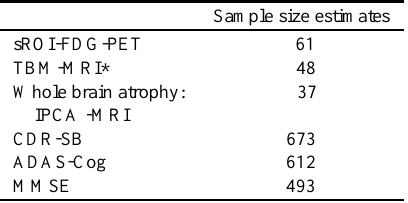
Table 1 Treatment trial sample size estimates using FDG PET and MRI morphometry compared to clinical measures as primary endpoints for